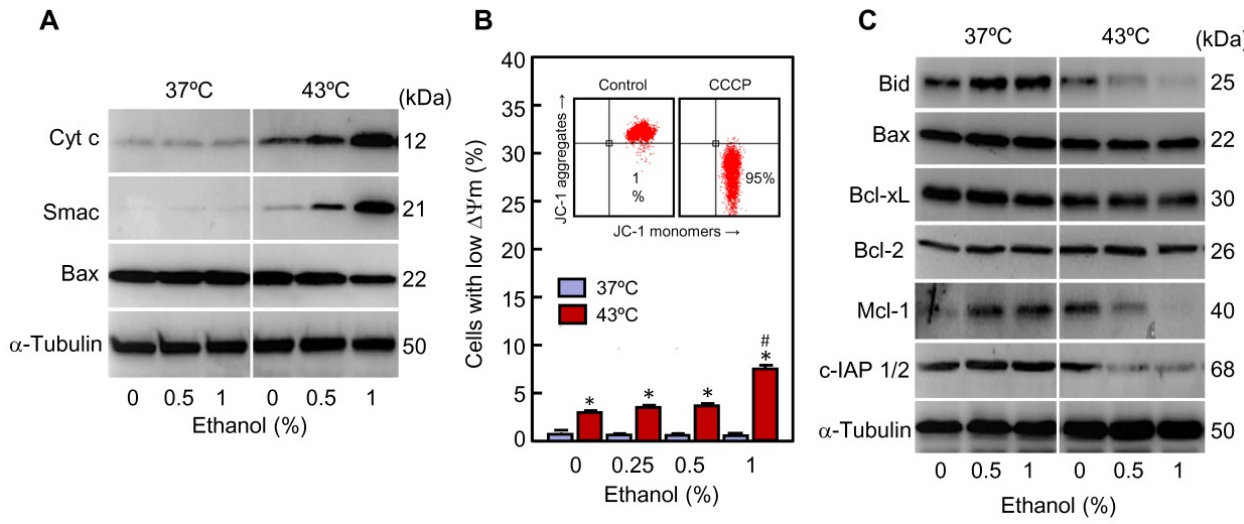
Figure 5. Effect of ethanol on pro-apoptotic and anti-apoptotic factors involved in the mitochondrial pathway of apoptosis in U937 cells subjected to hyperthermia. ( A – C ) The cells were pre-incubated in absence or presence of the indicated concentrations of ethanol for 30 min, exposed to hyperthermia (30 min at 43 °C) and allowed to recover for 3 h. ( A ) Cytosolic fractions were isolated and analyzed by immunoblotting; α -tubulin was used as a loading control. ( B ) Mitochondrial transmembrane potential ( ∆ψ m) was evaluated by flow cytometry using the JC-1 probe (10 μ M) and expressed as percentage of cells with low mitochondrial transmembrane potential (low green fluorescence); cells treated with 50 μ M of CCCP for 30 min were used as a positive control (inserted dot plot). ( C ) Whole cell lysates were prepared and assayed by immunoblotting; as a loading control, α -tubulin was also determined. * p < 0.05 vs. the respective control at 37 °C; # p < 0.05 vs. hyperthermia (43 °C) treatment alone.